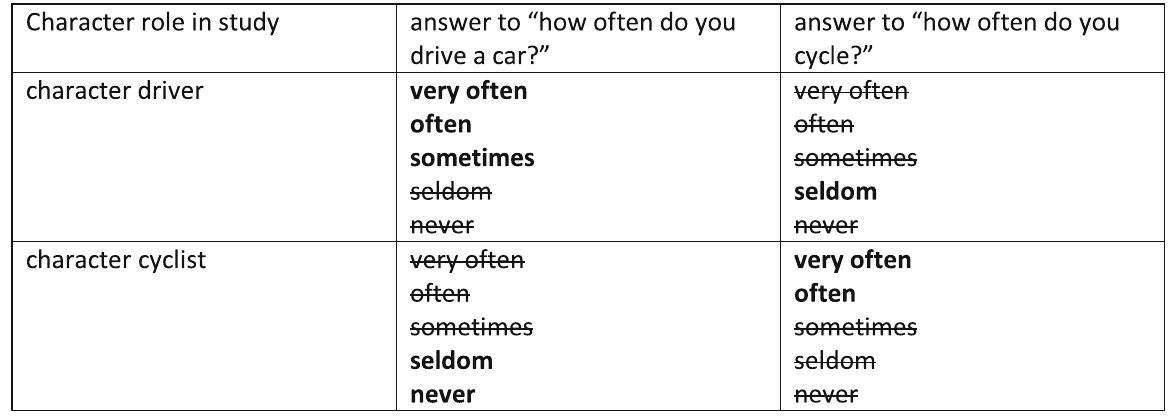
Strikethrough indicates alternatives disqualifying for that